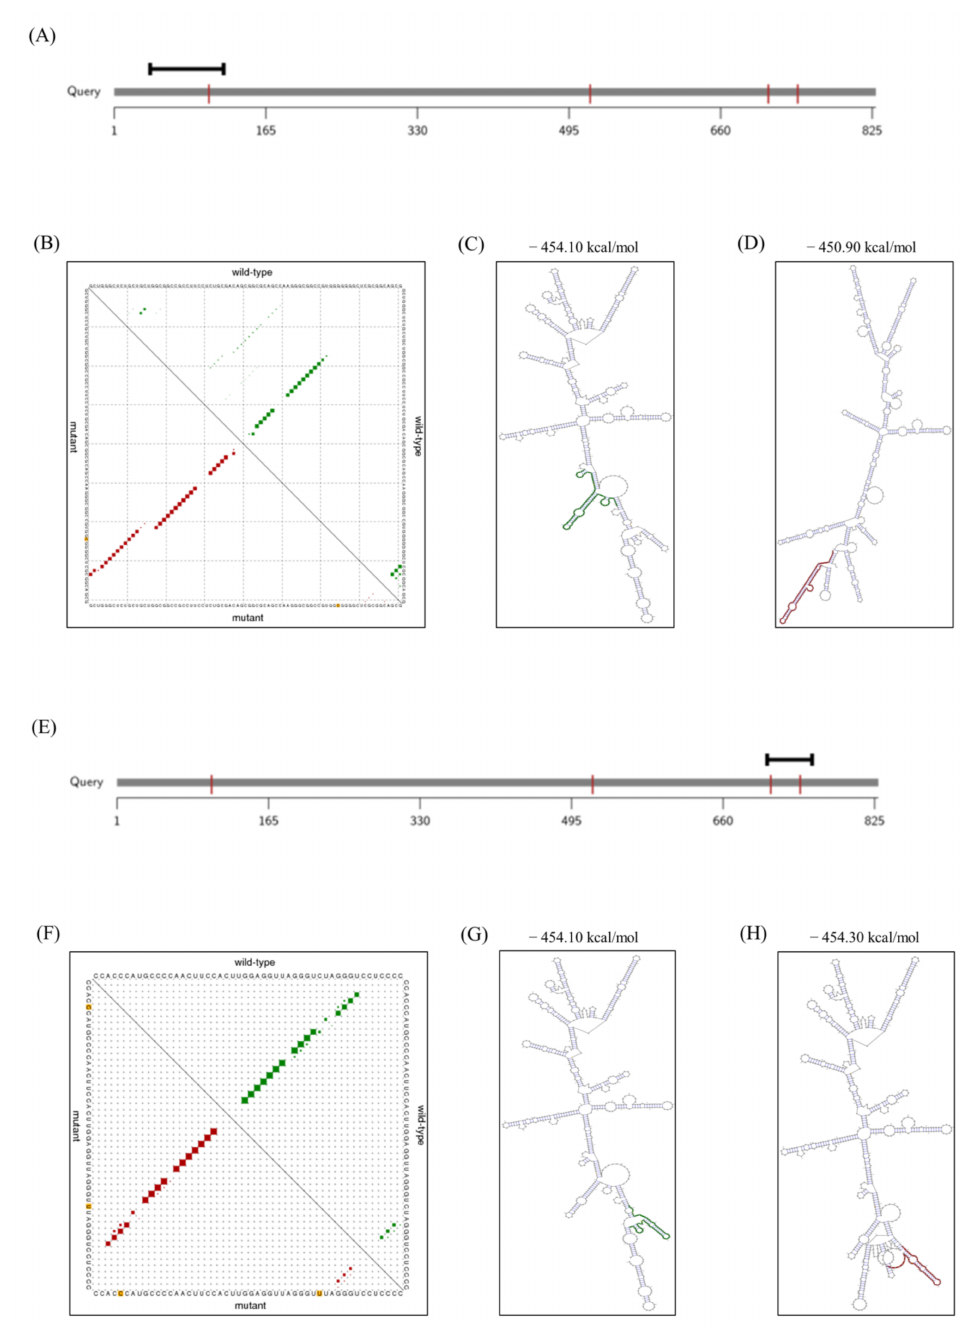
Figure 3. Comparisons of mRNA secondary structure of the equine SPRN gene between GCCC and CTTT haplotypes, and between GCCC and GCCT haplotypes. ( A ) The graphical overview shows the location of the predicted local region over the query sequence (GCCC vs. CTTT haplotypes) ( B ) Dot plot represents the base pair probabilities of the mRNA secondary structure. The upper triangle represents the probabilities for the equine SPRN gene with GCCC haplotype (green) and the lower triangle represents those for the equine SPRN gene with CTTT haplotype (red). ( C ) Minimum free energy and mRNA secondary structure of the equine SPRN gene with GCCC haplotype. ( D ) Minimum free energy and mRNA secondary structure of the equine SPRN gene with CTTT haplotype. ( E ) The graphical overview shows the location of the predicted local region over the query sequence (GCCC vs. GCCT haplotypes). ( F ) Dot plot represents the base pair probabilities of the mRNA secondary structure. The upper triangle represents the probabilities for the equine SPRN gene with GCCC haplotype (green) and the lower triangle represents those for the equine SPRN gene with GCCT haplotype (red). ( G ) Minimum free energy and mRNA secondary structure of the equine SPRN gene with GCCC haplotype. ( H ) Minimum free energy and mRNA secondary structure of the equine SPRN gene with GCCT